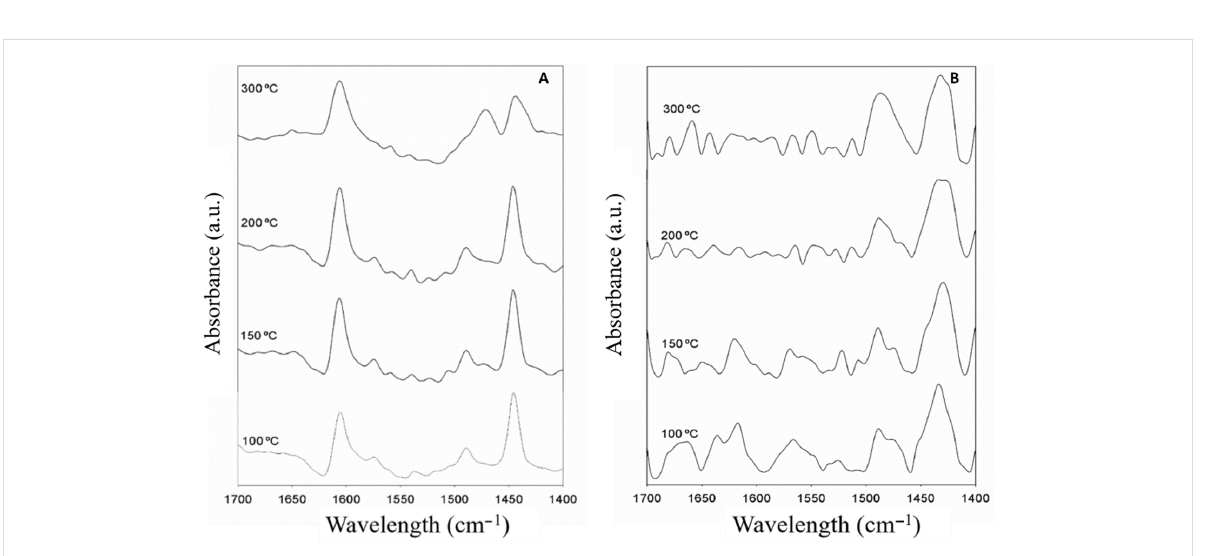
Figure 4: DRIFT spectra of A: TiO 2 -Fe 2 O 3 -PS4 and B: Fe 2 O 3 -PS4-MNP